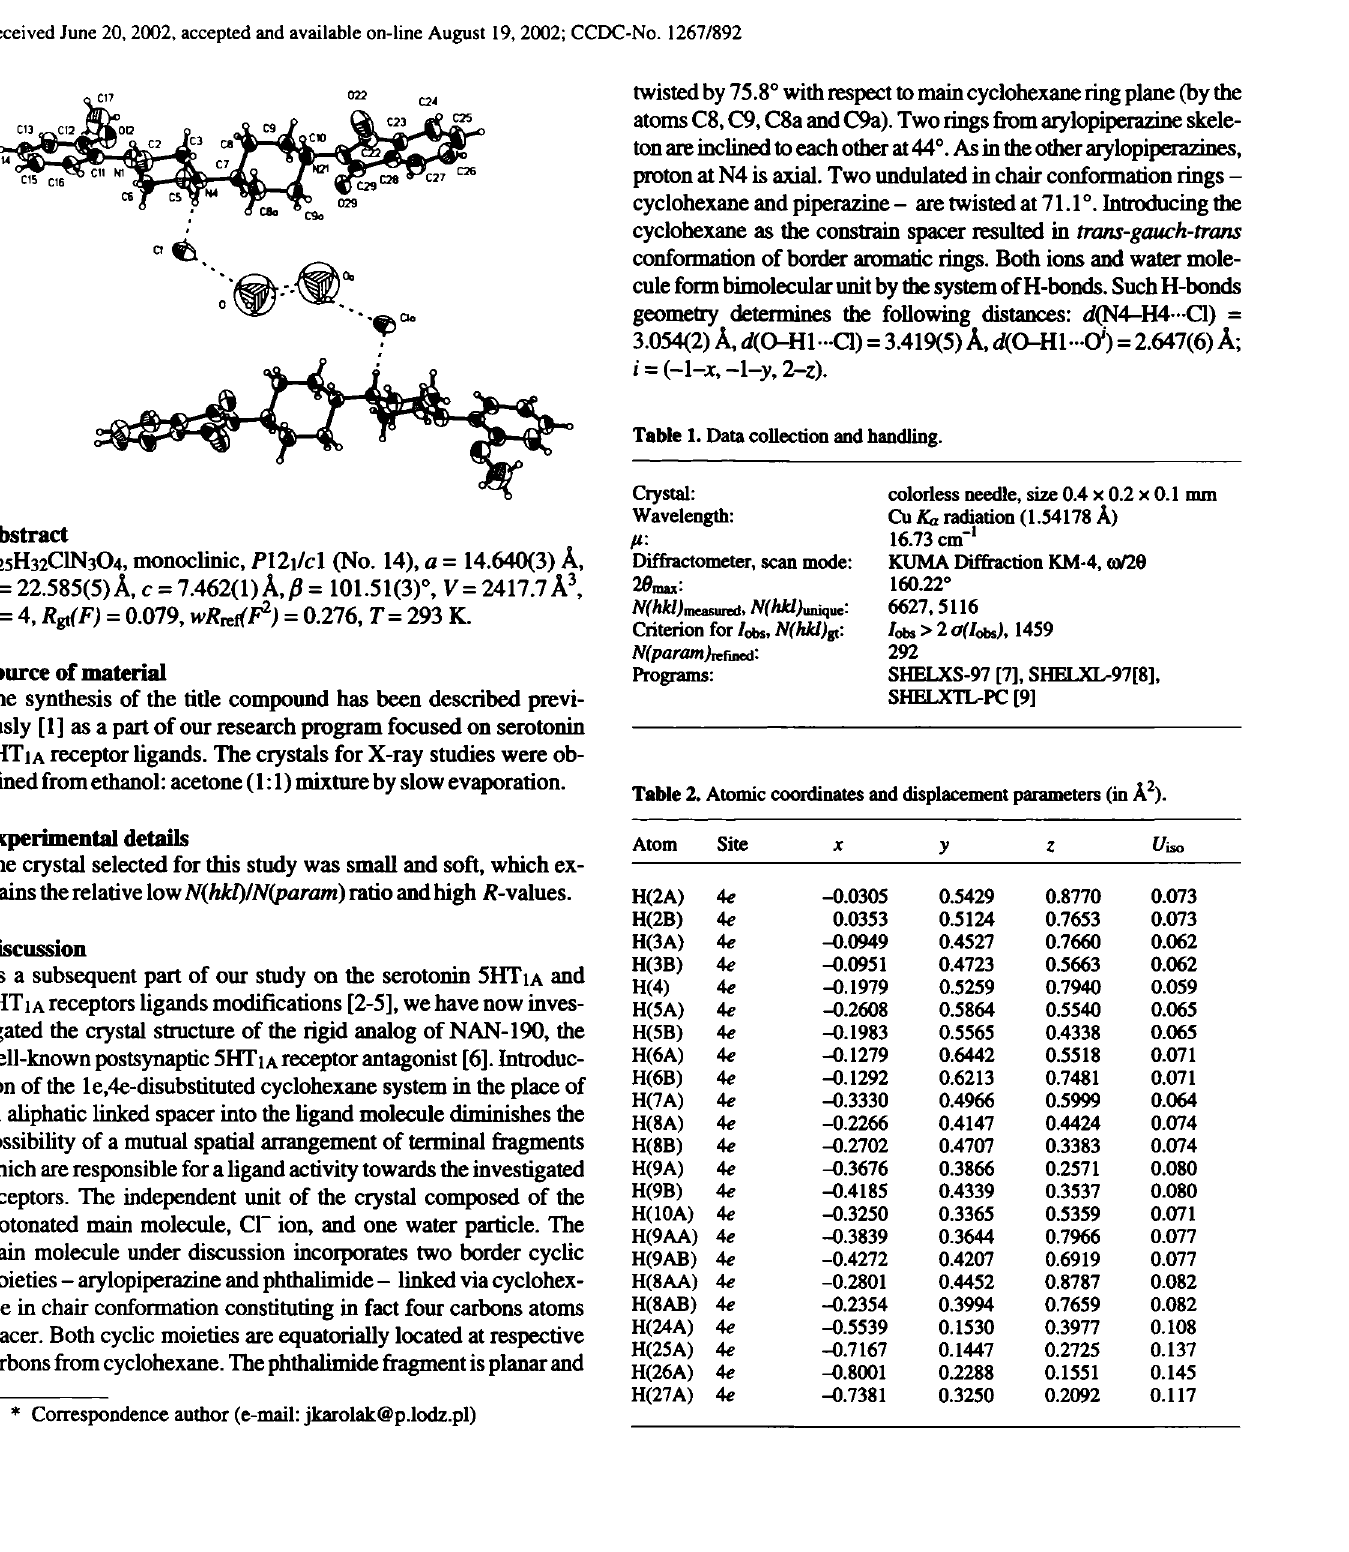
Table 1. Data collection and handling.